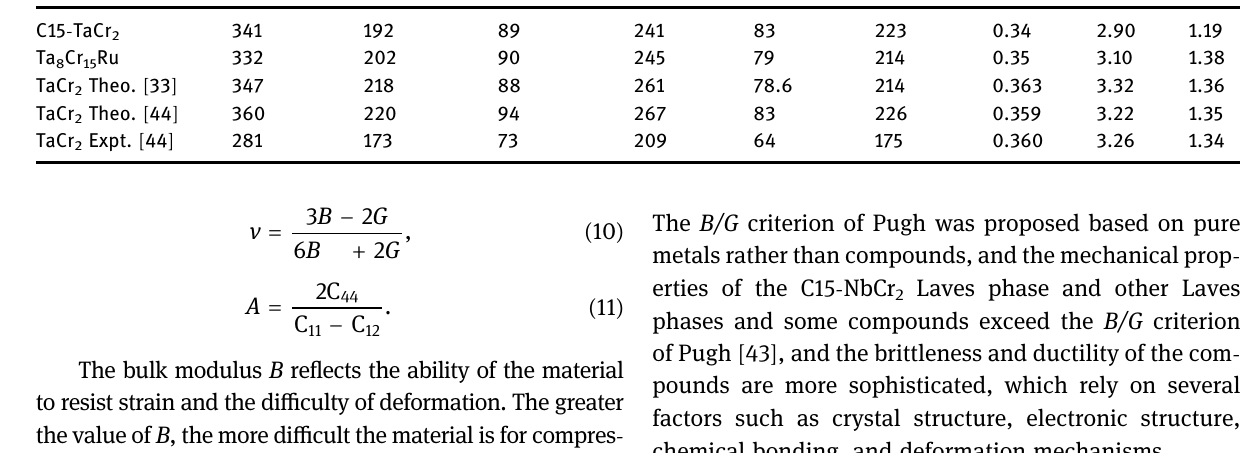
Table 4: Elastic constants for C15 - TaCr 2 and Ta 8 Cr 15 Ru Crystals